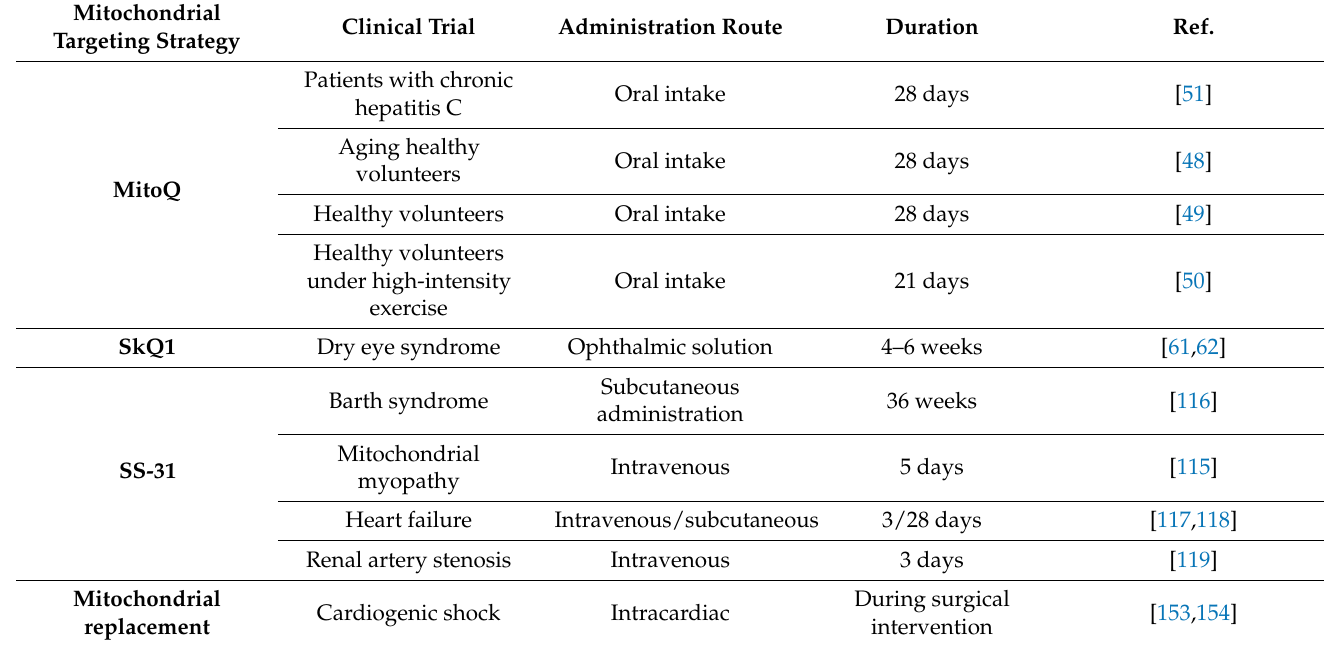
Table 1. Mitochondrial targeting strategies have already been tested in clinical